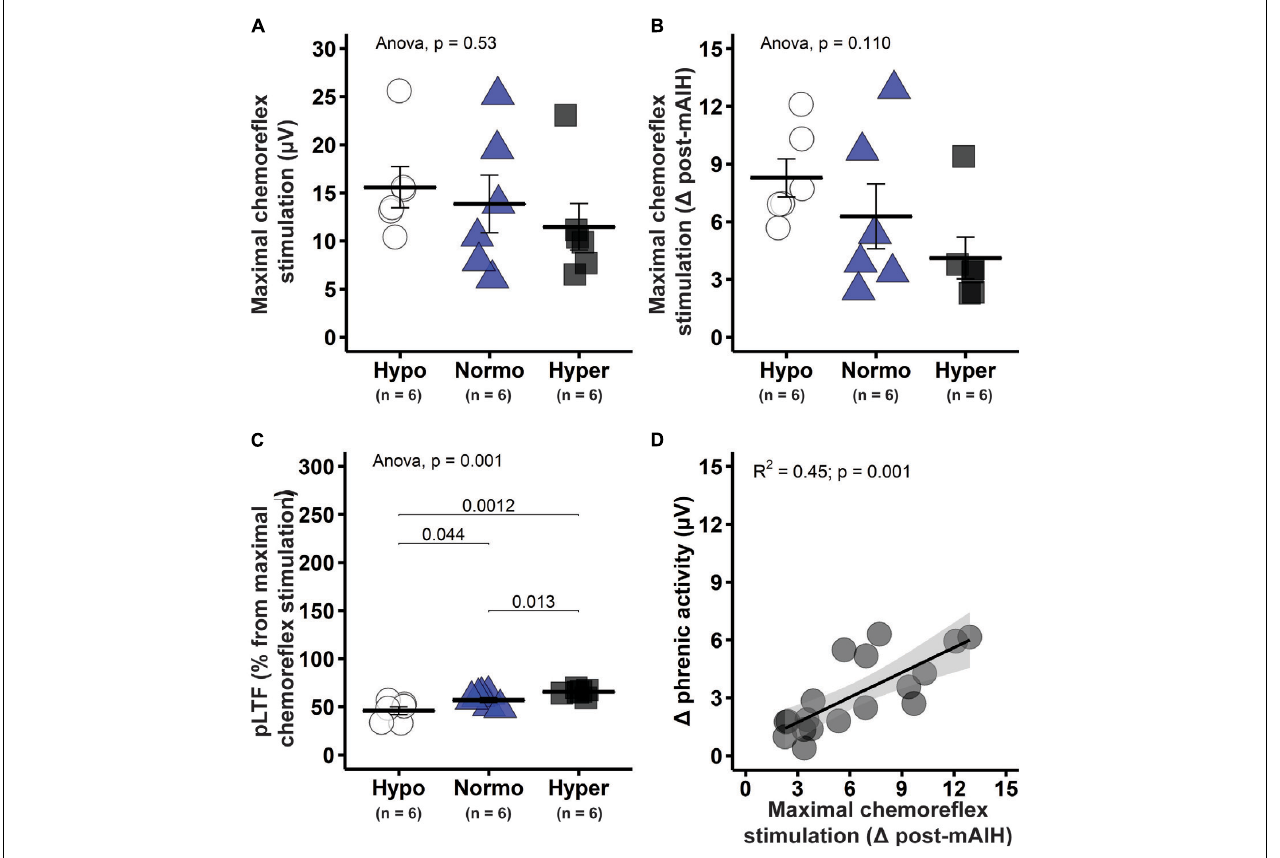
FIGURE 6 | Maximal chemoreflex stimulation (MCS) tended to be greater in hypocapnic rats, suggesting enhanced capacity following mAIH. (A) Group average phrenic response to maximal chemoreflex stimulation in absolute burst amplitude values. (B) Average phrenic response to maximal chemoreflex stimulation as delta burst amplitude from 60 min post-mAIH (pre-stimulus level). (C) Average magnitude of phrenic long-term facilitation (pLTF) as percent from maximal chemoreflex stimulation. (D) Linear regression between phrenic response to maximal chemoreflex stimulation [data from panel (B) ] and delta phrenic burst amplitude from baseline to 60 min post-mAIH. Data are presented as mean ± standard error of the